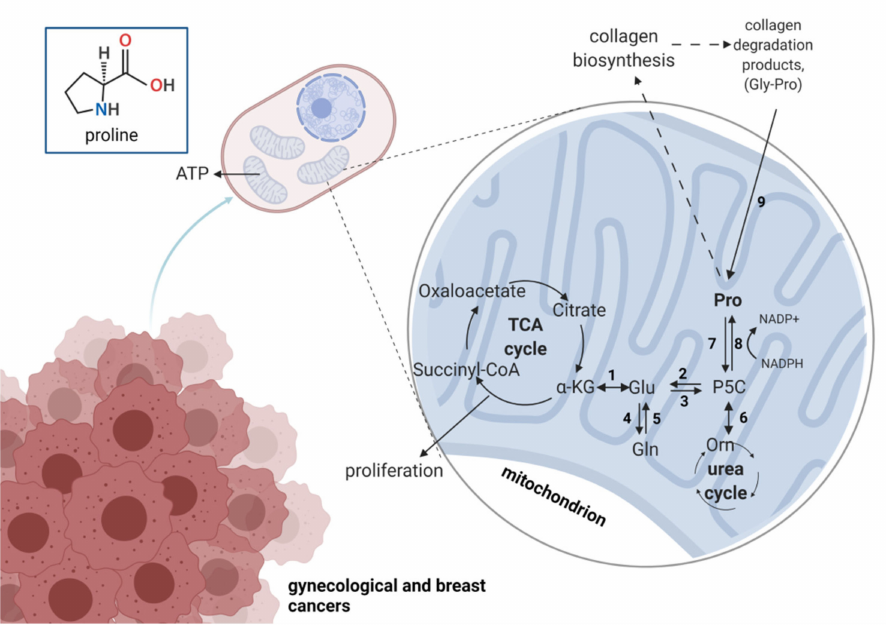
Figure 5. The overview on proline metabolism in gynecological cancers. Numbers represent en- zymes involved in proline-relation reactions: 1—glutamate dehydrogenase; 2—P5C